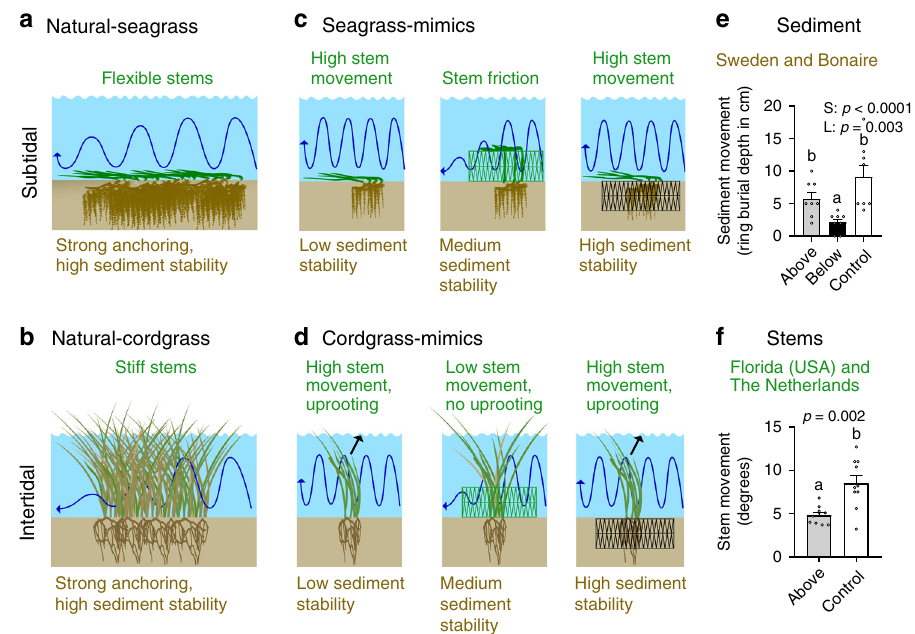
Fig. 5 Species-speci fi c facilitation mechanisms. Both cordgrass and seagrass increase sediment stability with their root mats, but stiff cordgrass stems also attenuate hydrodynamic energy (blue arrow), while fl exible seagrass shoots avoid drag by bending ( a , b ). Small cordgrass and seagrass transplants cannot self-facilitate, making them vulnerable to uprooting (black arrow). Application of trait-based mimicry allows simulating self-facilitation naturally occurring in mature vegetation stands ( c , d ). Belowground establishment structures simulate a dense root mat, while aboveground structures mimic dense patches of stiff cordgrass stems. Field measurements in Sweden and Bonaire con fi rm sediment stabilization by aboveground establishment structures, but even more by belowground structures ( e ). Flume experiments demonstrate that aboveground structures greatly reduce cordgrass stem movement when subjected to 70-mm-high waves (( f ), n = 10). Panel e shows sediment mobility grouped for Sweden and Bonaire (ring burial depth in cm, n = 8). Main effects (S structure, L location) are shown with p values (two sided); signi fi cant contrasts with letters ( p < 0.05, Tukey corrections for multiple comparisons). Exact p values are shown when p > 0.0001. Data are presented as mean values + SEM. Results of the statistical analyses are presented in Supplementary Table 3. Source data are provided as a Source Data fi le. Symbols for diagrams courtesy of the Integration and Application Network, IAN Image Library